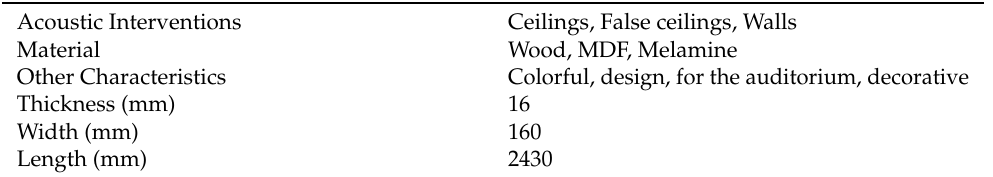
Table 2. Technical characteristics of the